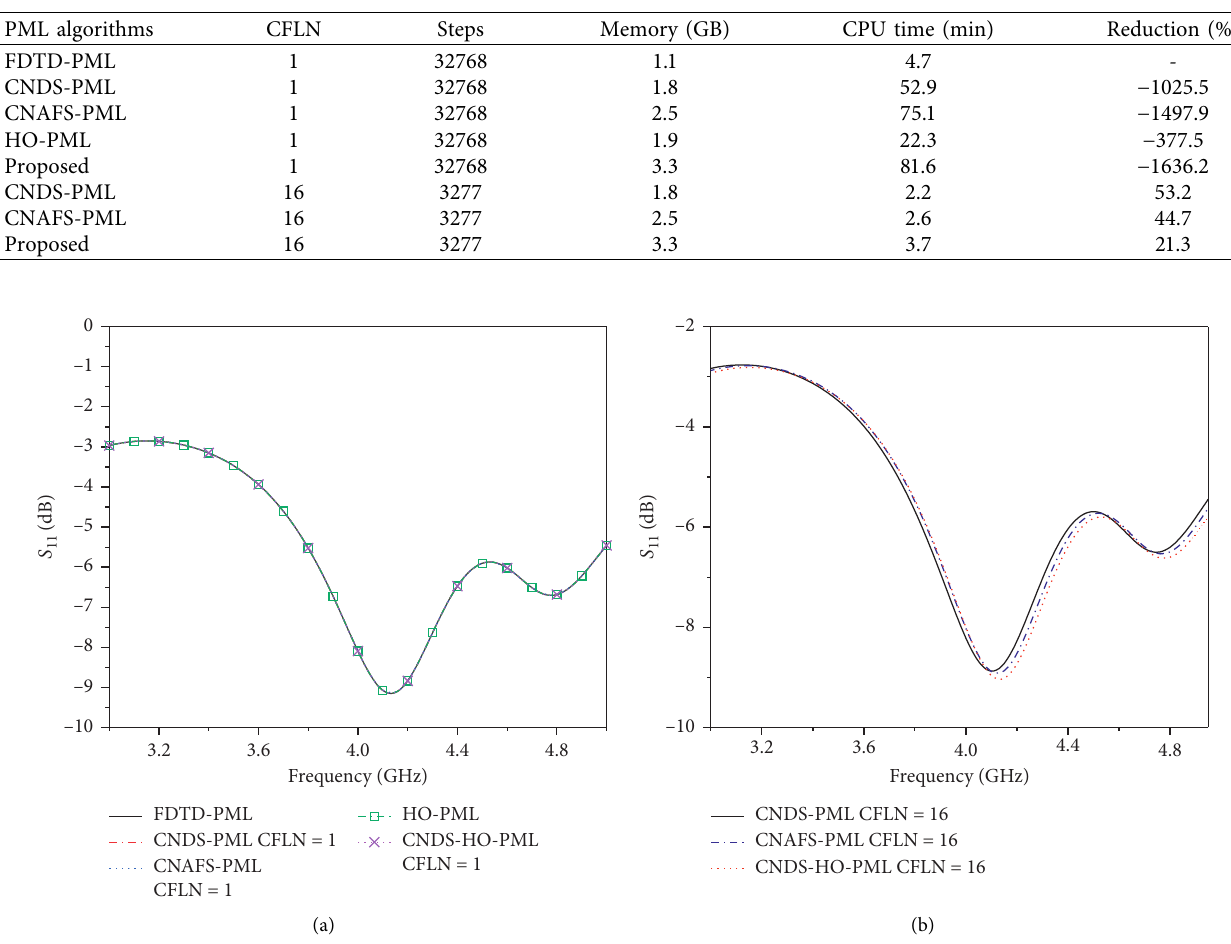
Figure 8: The S 11 versus frequency obtained by (a) FDTD-PML, CNDS-PML, CNAFS-PML, HO-PML, and CNDS-HO-PML when CFLN � 1 (b) CNDS-PML, CNAFS-PML, and CNDS-HO-PML when CFLN � 16.